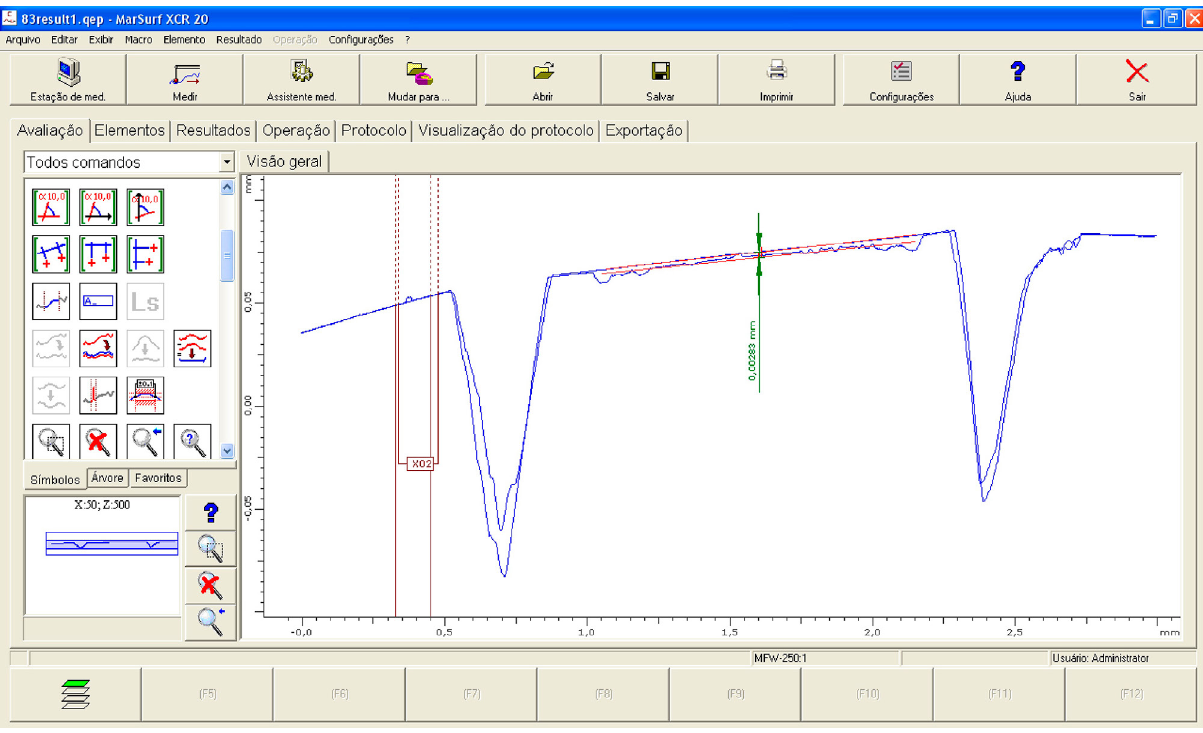
Figure 2- Superimposition of initial and final profiles and measurement of enamel